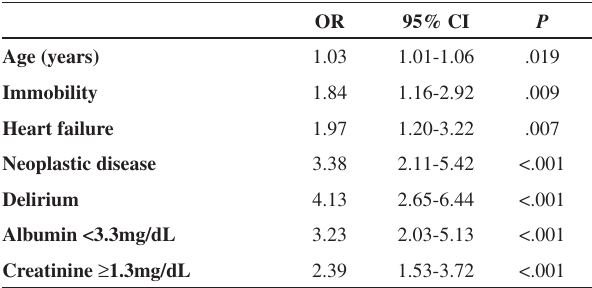
Table 2- Independent in-hospital mortality predictors